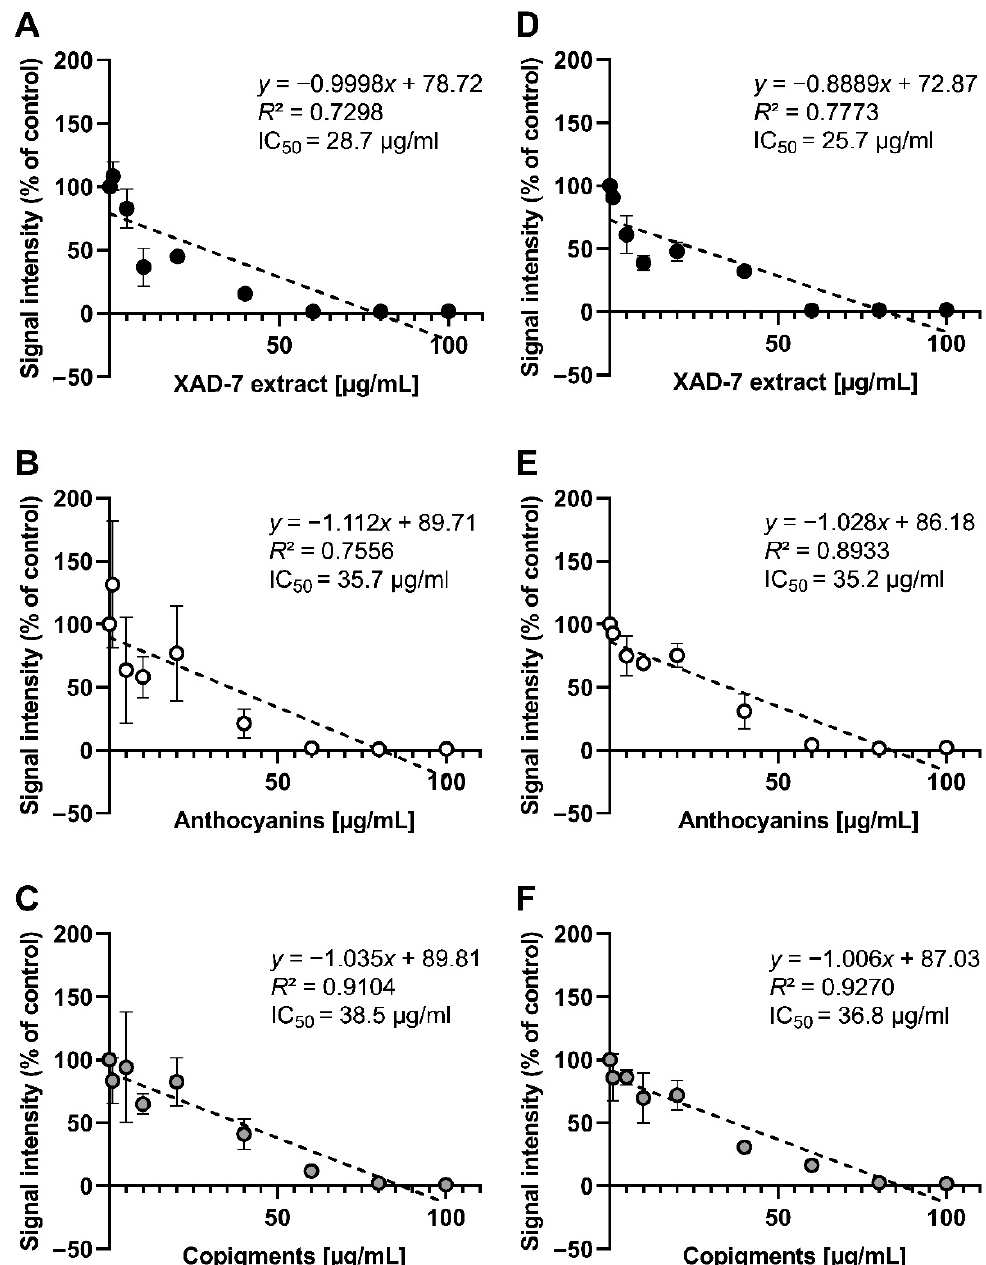
Figure 4. Total antioxidant galvinoxyl radical ( A – C ) and DPPH radical ( D – F ) scavenging activity of pomegranate XAD-7 extract and its fractions determined by electron spin resonance (ESR) spectroscopy. Shown is the mean ± SD, the linear equation, as well as the calculated R 2 and IC 50 values of three independent experiments .